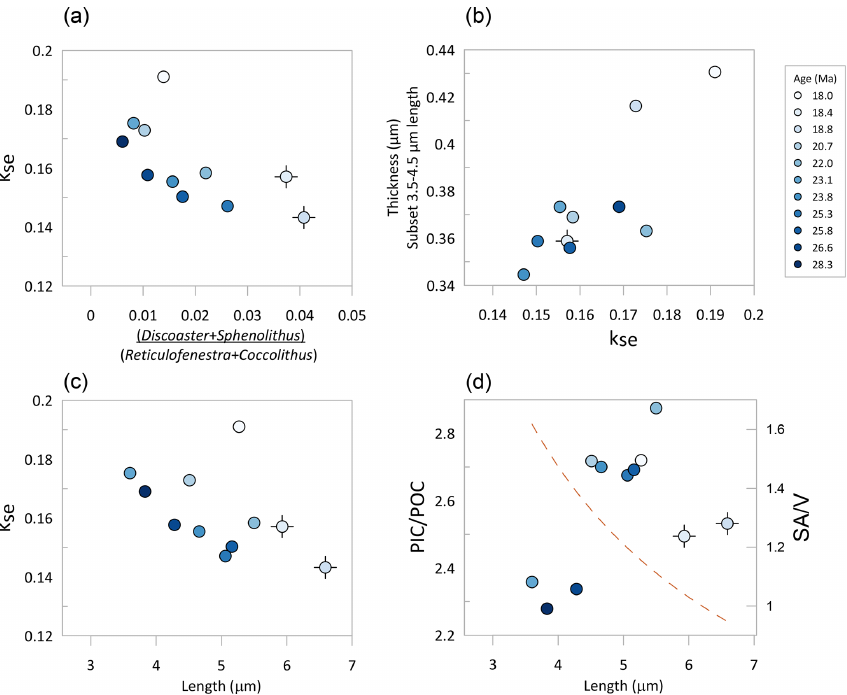
Figure 8. Relationship among median “reticulofenestrids” morphological parameters of the 11 populations examined. (a) Relative abundance of dissolution-resistant taxa vs. Reticulofenestra k se . (b) Median thickness of all Reticulofenestra with length between 3.5 and 4.5µm and k se . (c) Median k se vs. median length. (d) Estimated PIC / POC ratio for the assumptions described in the text vs. length. The dashed brown line indicates the decrease in the ratio of surface area to volume (SA /V ) of a spherical cell corresponding to the diameter estimated from the median lith length. In all panels, the symbol color indicates the age of examined sediment. The black cross beneath the symbol indicates samples with dissolution-resistant taxa exceeding